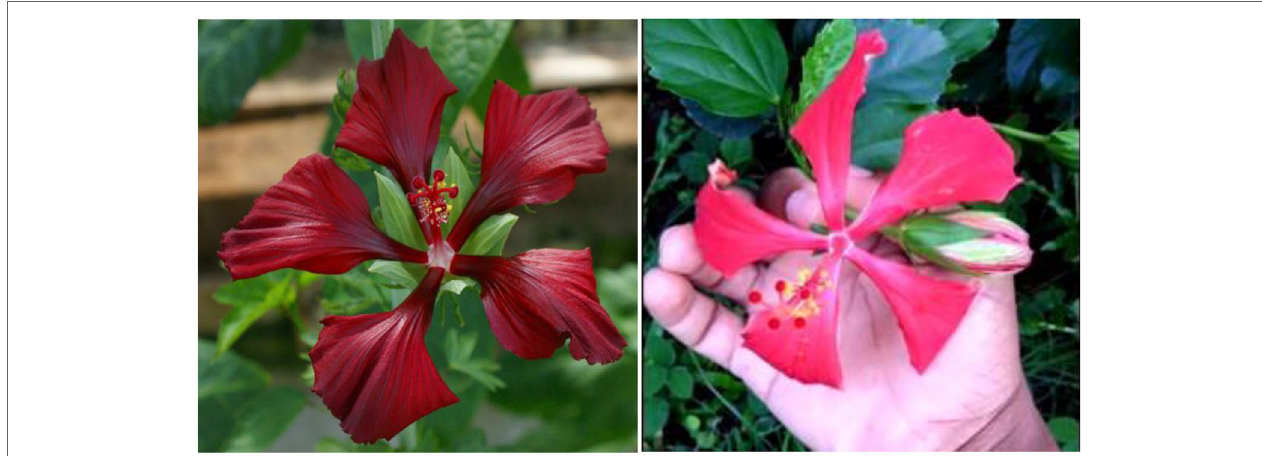
FIGURe 10 | Flower color and shape of H. x moscheutos hybrid “15199 ST” (left) and an unnamed H. rosa-sinensis hybrid (right). Photo credits: Dariusz P. Malinowski (15199 ST”) and George C. Charles ( H. rosa-sinensis hybrid), Mauritius. Used with permission.